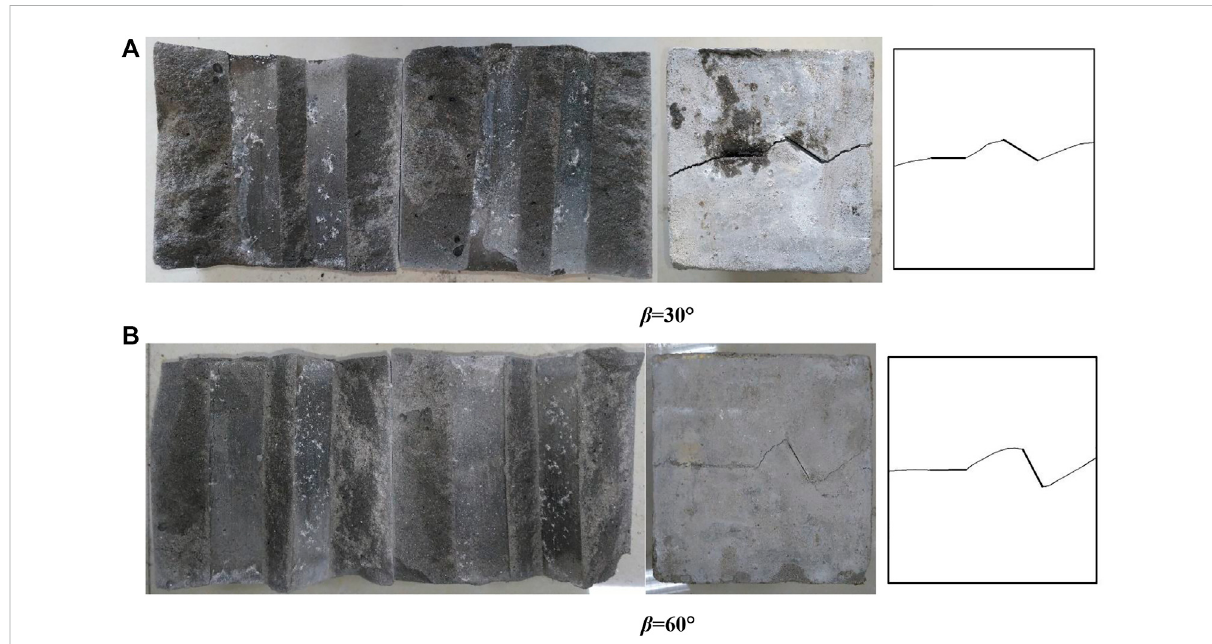
FIGURE 8 Shear failure surface and form of specimens under normal stress of 1 MPa ( α = 180 ° ). (A) β = 30 ° , (B) β = 60 ° .